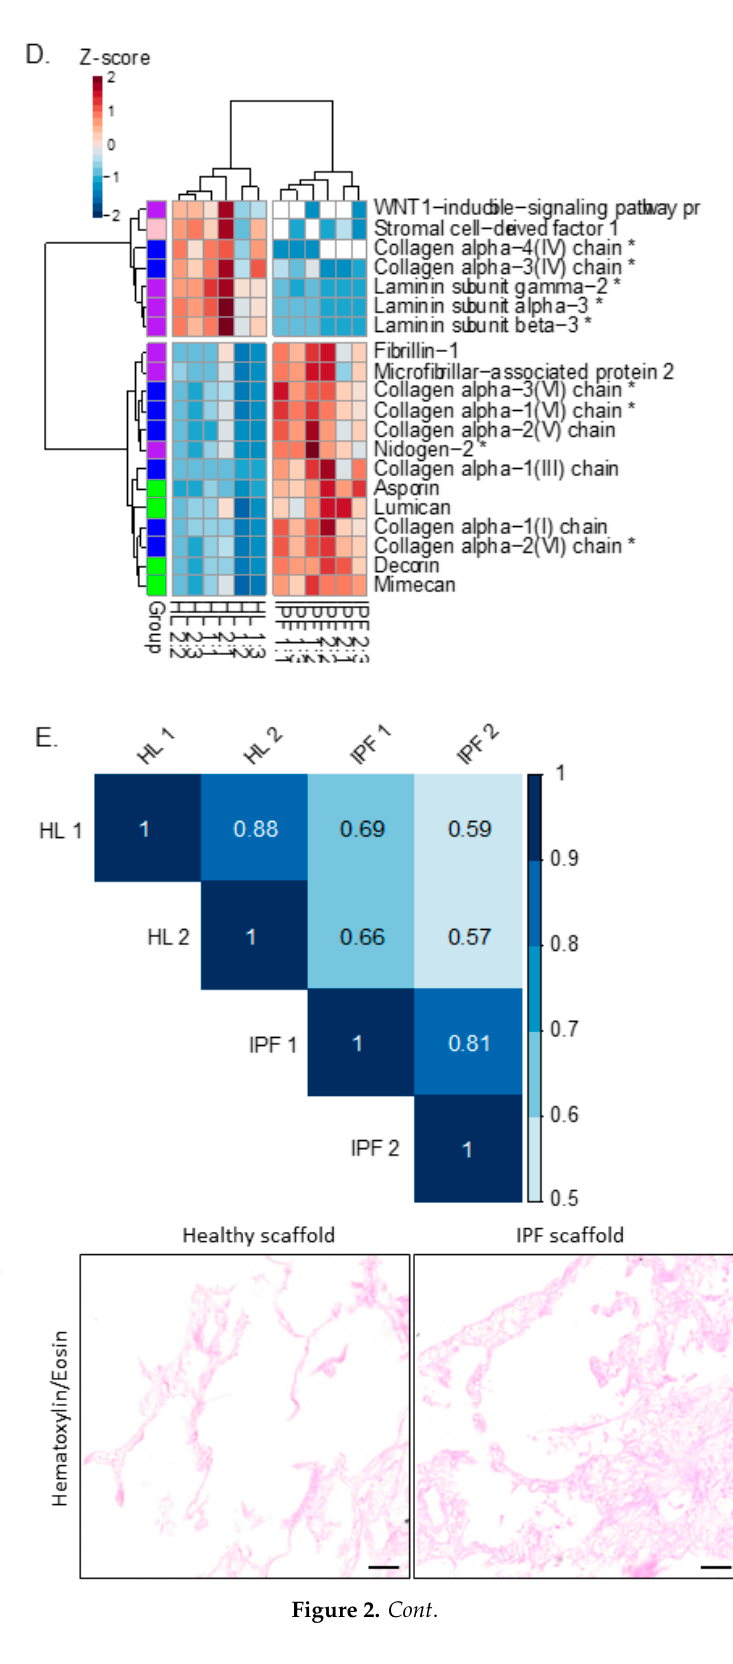
Figure 2. Proteomic and histological characterization of healthy and IPF derived tissue scaffolds. ( A ) Number of identified proteins in decellularized scaffolds derived from healthy individuals (biological replicates n = 2, technical replicates n = 3) and IPF patients ( n = 2, n = 3). Protein groups assigned to matrisome affiliation. ( B ) Matrisome grouped summed raw intensities for proteins in healthy and IPF derived scaffolds, left panel. Matrisome grouped summed intensities after density adjustment in healthy and IPF scaffolds, right panel. Mean values for groups presented. ( C ) Statistics for summed matrisome groups. Student’s t -test with Benjamini-Hochberg corrected p -values * p < 0.05. ( D ) Unsupervised hierarchical clustering of significantly different matrisome proteins characteristic for the scaffold types using Z-scored values. Basement membrane proteins marked with *. ( E ) Spearman correlation between scaffold groups. ( F ) Histological verification and spatial tissue distribution of selected matrisome (or basement membrane) proteins. Hematoxylin/Eosin staining showing distinct morphological differences between thin, alveolar septa (healthy scaffold) compared to thickened, fibrotic remodeled septa (IPF scaffold). ( G ) This is accentuated (arrows) by staining for collagen type IV (brown), indicating clear basement membrane staining lining the alveolar septa in the healthy scaffold compared to disorganized fragments in the IPF scaffold, with large areas devoid of collagen type IV signal or reduced intensity (*). ( H ) Inversely, collagen type VI showed accumulation in these fibrotic structures in the IPF scaffold. Scale bar 50 µm.